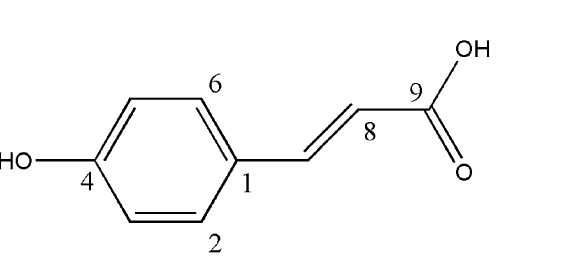
Figure 4. The structure of compound 2 .